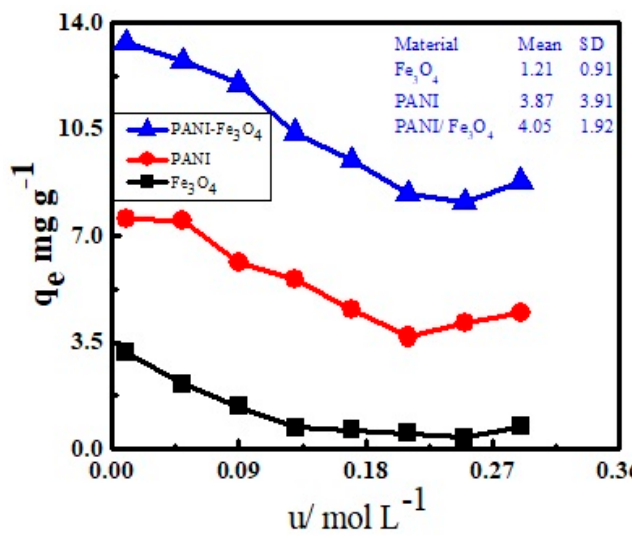
Figure 8. E ff ect of ionic strength on adsorption of BB3 on Fe 3 O 4 , PANI, and PANI / Fe 3 O 4 composites. Figure 8. Effect of ionic strength on adsorption of BB3 on Fe 3 O 4 , PANI, and PANI/Fe 3 O 4 composites.